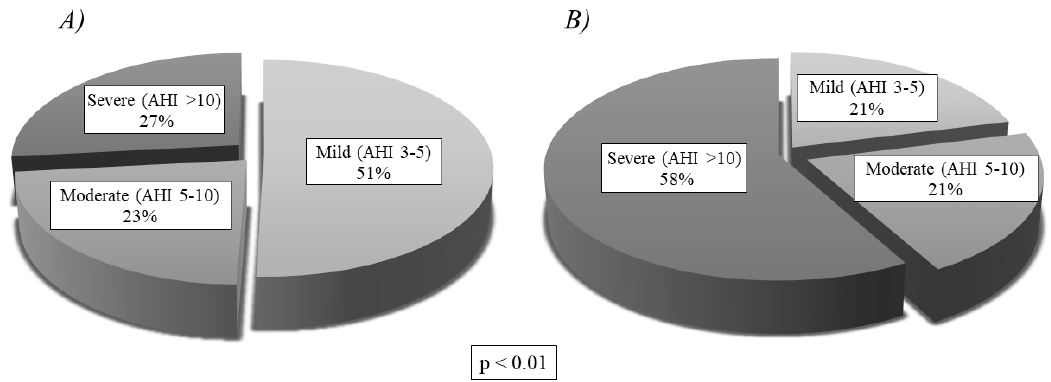
Table 6. Therapeutic approach by group. Group A (HRP) % (n)